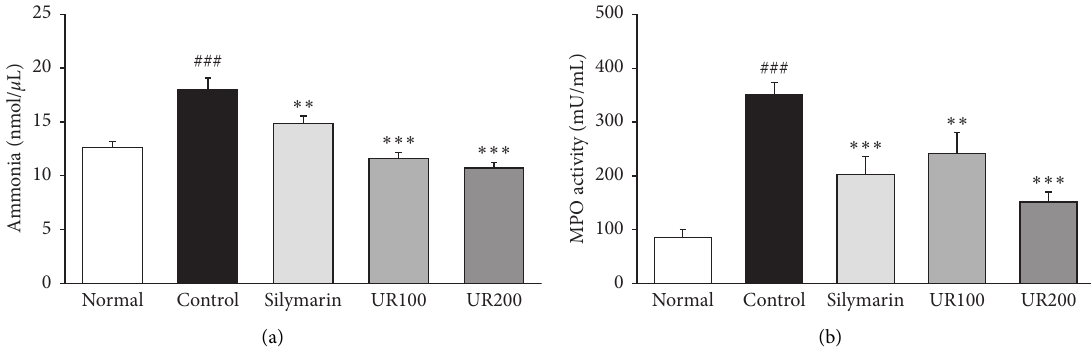
Figure 3: Effect of UR on serum ammonia and MPO levels. (a) Effects of UR on serum ammonia level in rats. (b) Effects of UR on serum MPO level in rats. Data are expressed as the mean ± SEM ( n � 7). Significance: ### p < 0 . 001 vs. the normal group and ∗∗ p < 0 . 01 and ∗∗∗ p < 0 . 001 vs. the ALI control